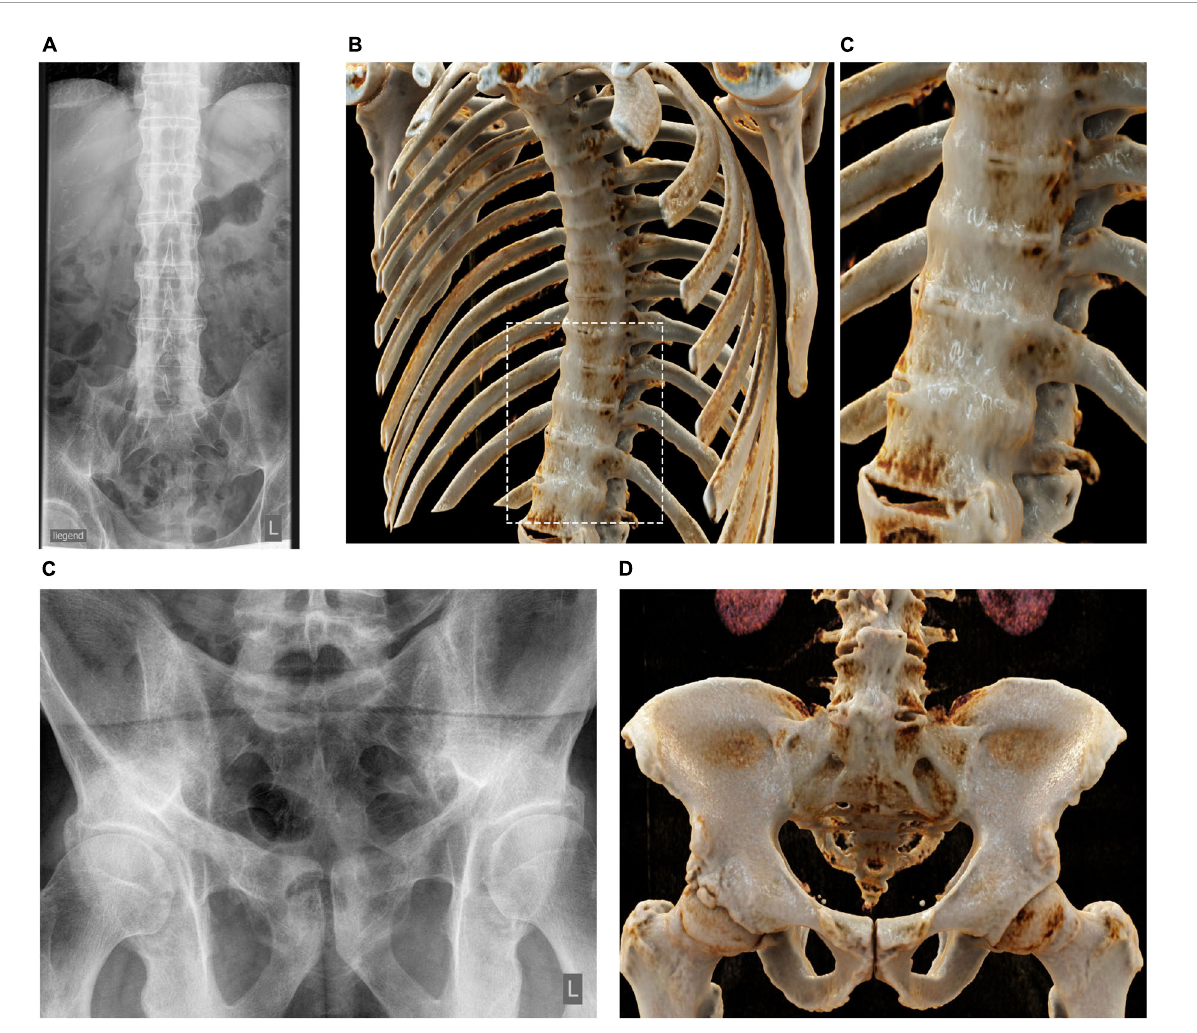
FIGURE1 Cinematic rendering of the spine and ribs in axial spondyloarthritis (axSpA). (A) Conventional radiographs of the spine of a patient with axSpA showing syndesmophyte formation (bamboo spine). Cinematic rendering (CR) based on conventional CT images impressively illustrates the extent of the connected syndesmophytes wrapping around the thoracic spine and the ribs (B) and the lower thoracic spine where syndesmophyte formation is depicted in photorealistic way walling the spine [close-up (C) ]. (D) Conventional radiographs of the pelvis of a patient with axSpA (left) showing sacroiliac ankylosis. Corresponding CR image showing the range of typical pathologies such as ankylosis or ubiquitous osteoproliferation along the iliac crest in photorealistic quality (D)